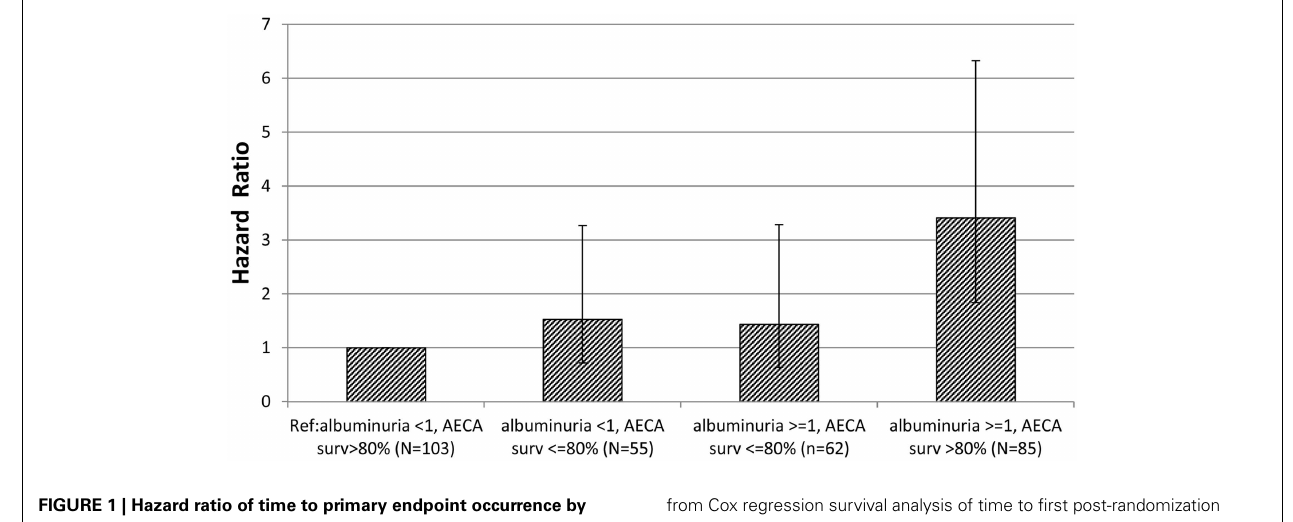
FIGURE 1 | Hazard ratio of time to primary endpoint occurrence by AECA-mediated cell survival, albuminuria subgroup is shown .The hazard ratio (bar height) and 95% confidence intervals (brackets) were computed